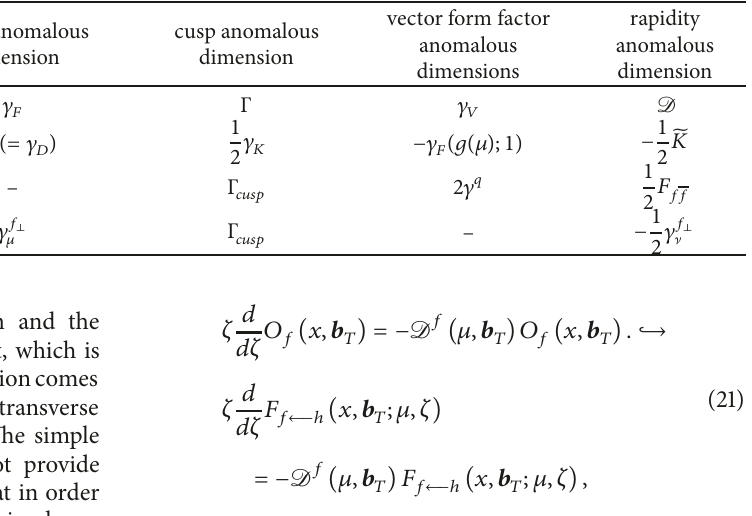
Table 2: Notation for TMD anomalous dimensions used in the